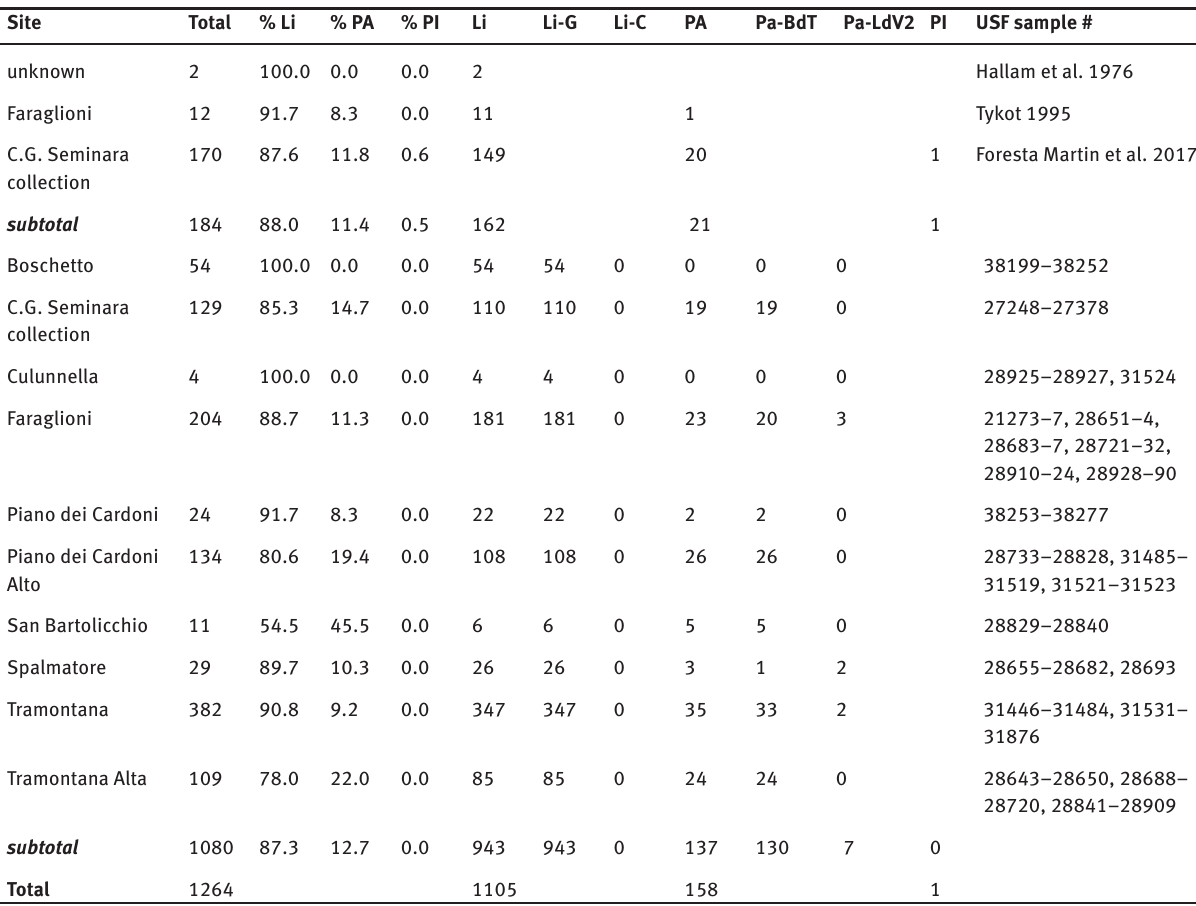
Table 1: Summary of the 1080 artifacts in this study from 9 sites and one collection and their source assignments, and 184 from previous pub- lications. Li-G = Lipari-Gabellotto, Li-C = Lipari-Canneto Dentro, Pa-BDT = Pantelleria-Balata dei Turchi, Pa-LdV2 = Pantelleria-Lago di Venere 2, PI = Palmarola (Pontine